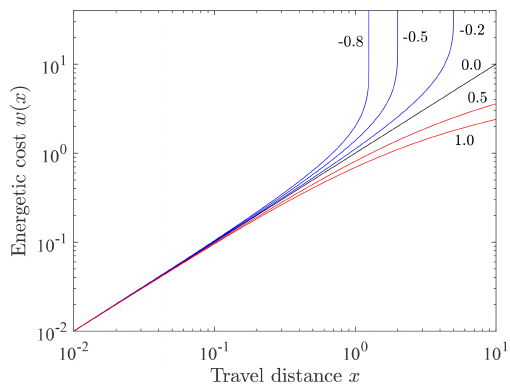
Figure 4. Plot of cumulative energetic cost w ( x ) versus distance x for several values of the shape parameter A representing net cooling ( A < 0, blue), isothermal conditions ( A = 0, black) and net heating ( A > 0,